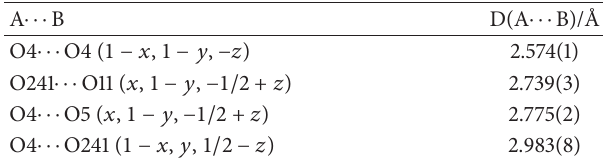
Table 2: Hydrogen bonding in the crystal structure of ( 1